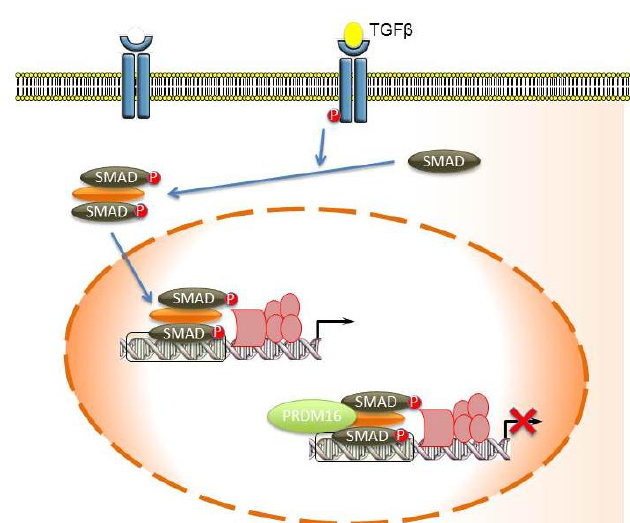
Figure 5. PRDM16 modulates TGF- (cid:533)(cid:3)